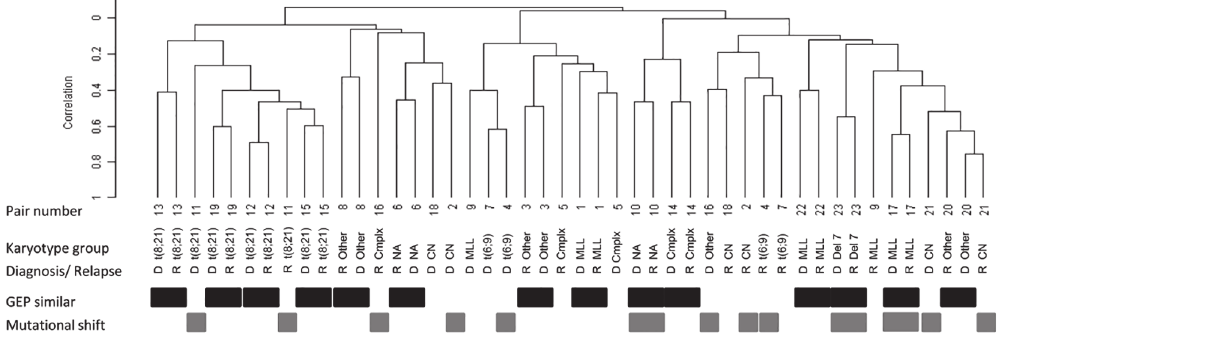
Fig 1. Hierarchical clustering dendrogram of paired initial and relapse AML samples. Similarity of GEP: Black bars indicate paired samples with GEP that correlate according to hierarchical cluster analysis. Grey bars indicate paired samples with mutational shifts between initial and relapse AML